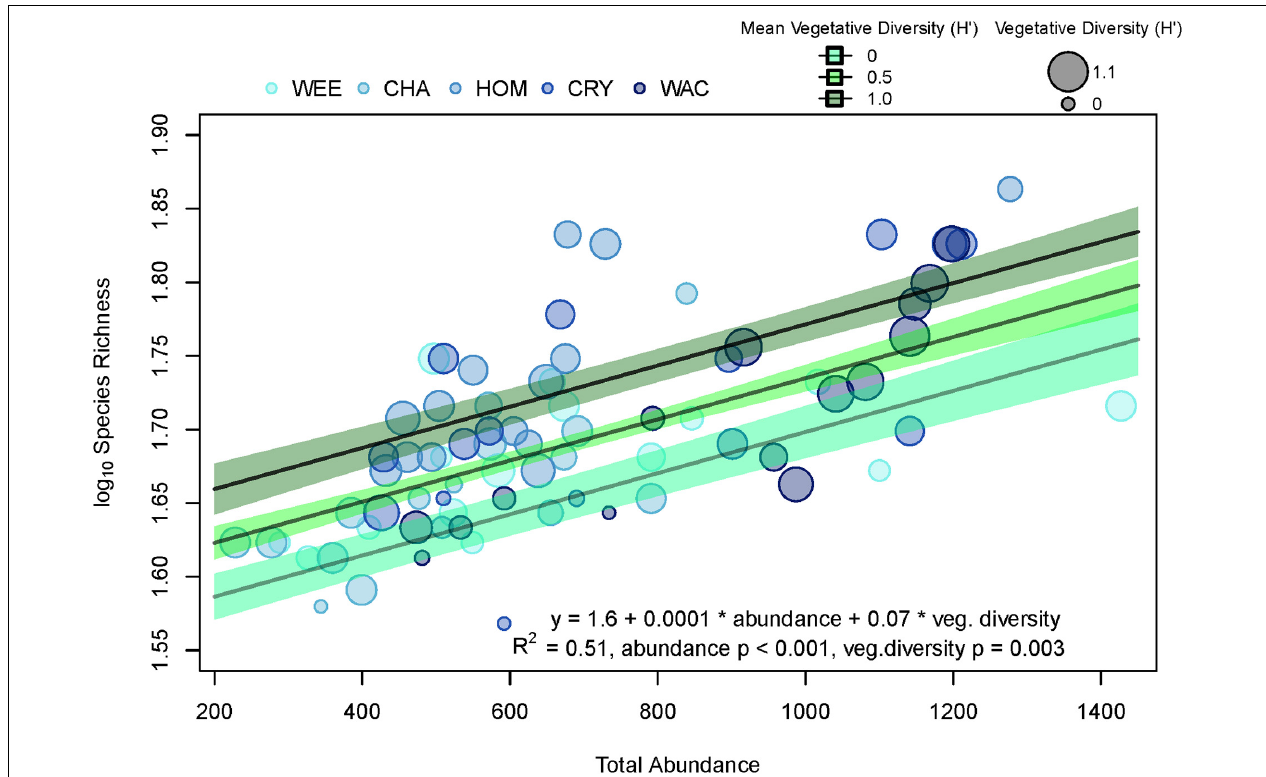
FIGURE 3 | Linear regression of log 10 species richness against total abundance and Shannon–Weaver vegetative diversity. WEE, Weeki Wachee; CHA, Chassahowitzka; HOM, Homosassa; CRY, Crystal River; WAC, Waccasassa. Three fitted lines (solid lines) were calculated from model fits by allowing total abundance to vary while holding vegetative diversity constant at three levels (0, 0.5, and 1). Green bands represent the 95% confidence intervals of the three fitted lines, with darker greens indicating higher vegetative diversity. Colors of points indicate relative levels of long-term total phosphorus (TP) concentrations in the water column, with lighter blues indicating lower TP. Sizes of points represent the vegetative diversity for individual samples, with larger sizes indicating higher vegetative diversity. *It is meant to signify multiplication.